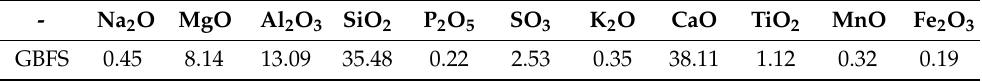
Table 3. Chemical composition of GBFS obtained with PARC (wt%).